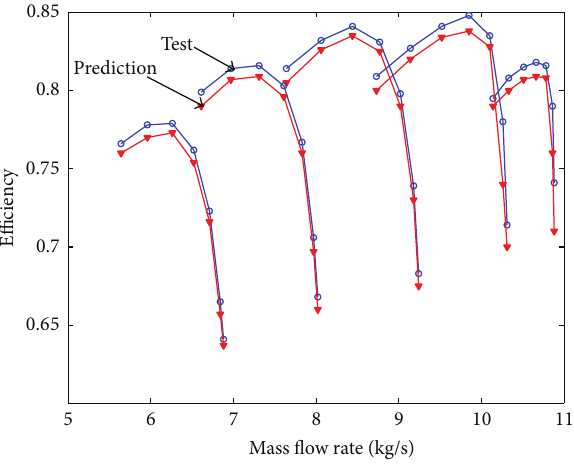
Figure 6: Efficiency characteristic curve for clean compressor.